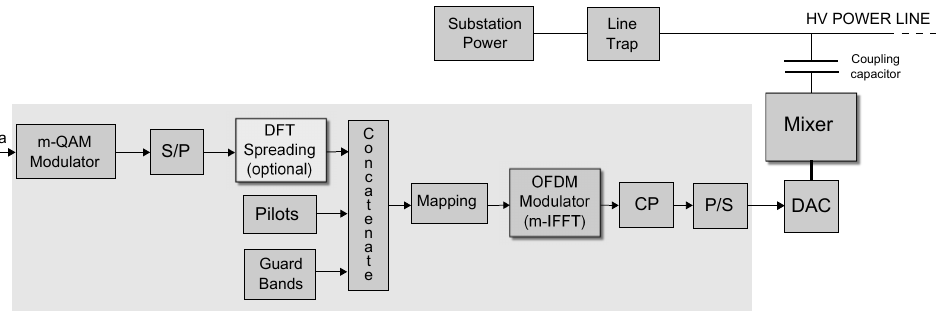
Figure 8. Models of the PLC-OFDM and SC-FDM PLC transmitters on the baseband processing stages. The OFDM symbols are subjected to the distortion effects of the PLC channel by means of a FIR filter, which replicates the characteristics found in the frequency-channel model. At the filter output, the AWGN and corona noise are added to the signal in order to replicate the PLC channel, as shown in Figure